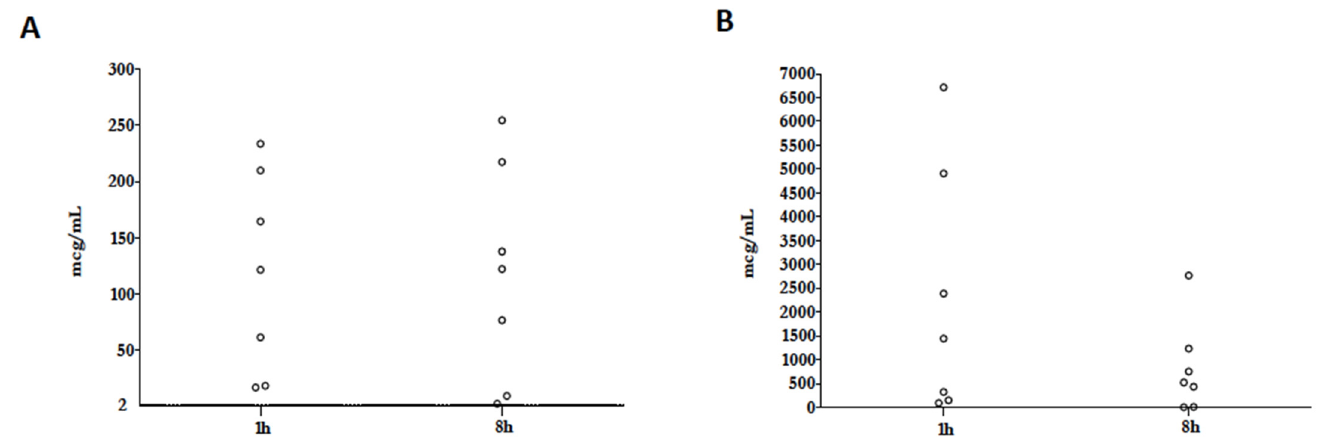
Figure 2. Colistin ( A ) and colistimethate ( B ) ELF concentrations. Data available from 7 patients’ ELF (epithelial lining fluid).